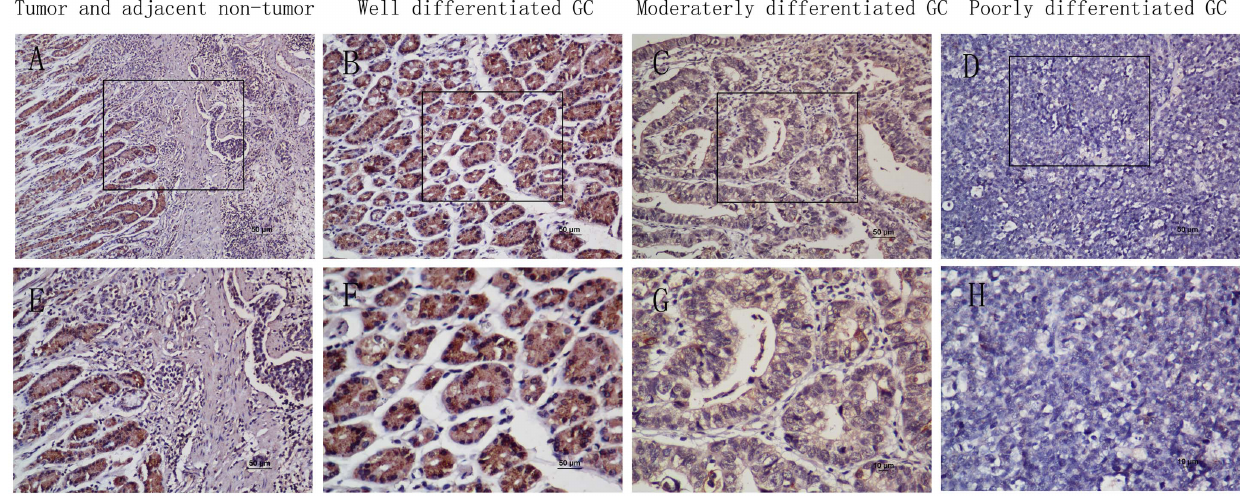
Figure 3. The in situ expression of UPK1A protein in gastric cancer specimens was assessed by immunohistochemistry. (A) and (E), Immuno-staining of a GC tumor and the adjacent non-tumorous area. (B) and (F), Strong UPK1A staining was observed in well-differentiated GC. (C) and (G), Weak UPK1A staining in moderately differentiated gastric cancer. (D) and (H), Negative UPK1A staining in poorly differentiated GC. (A–D with 200 6 magnification; E–H with 400 6